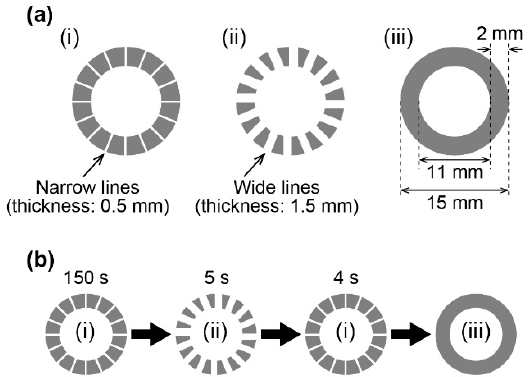
Figure 2. ( a ) Illustration of projected images (top view). ( b ) Time series of change in the projected